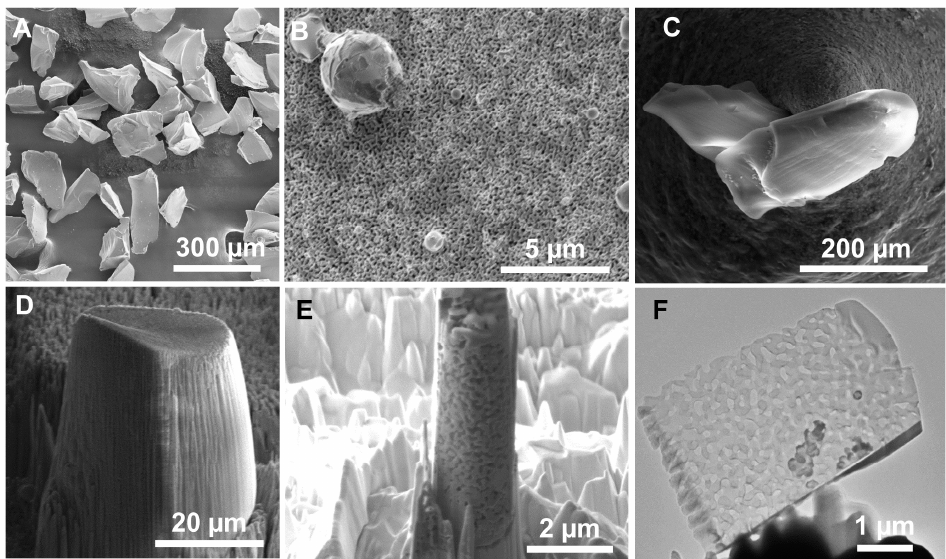
Figure 2. Correlative tomography workflow applied to SCALMS sample. ( A ) SEM overview image of the SCALMS primary particles after synthesis. ( B ) SEM image revealing the surface structure of the SCALMS system. Large droplets are dispersed on the surface of the macroporous glass. ( C ) SEM image showing two arbitrarily selected primary particles glued onto a tomography tip for further FIB preparation (top view). ( D ) SEM image of a FIB-prepared pillar (d ≈ 28 µm) for LFOV and stitched-HRES nano-CT experiments (reprinted with permission from Wirth et al., Cambridge University Press 2019 [15] ). ( E ) SEM image of a smaller pillar (d ≈ 2 µm), prepared from the larger pillar in ( D ), suitable for 360°-ET experiments. ( F ) Bright-field (BF) TEM image of a FIB-prepared lamella structure out of the pillar in ( D ) suitable for STEM-EDXS experiments.